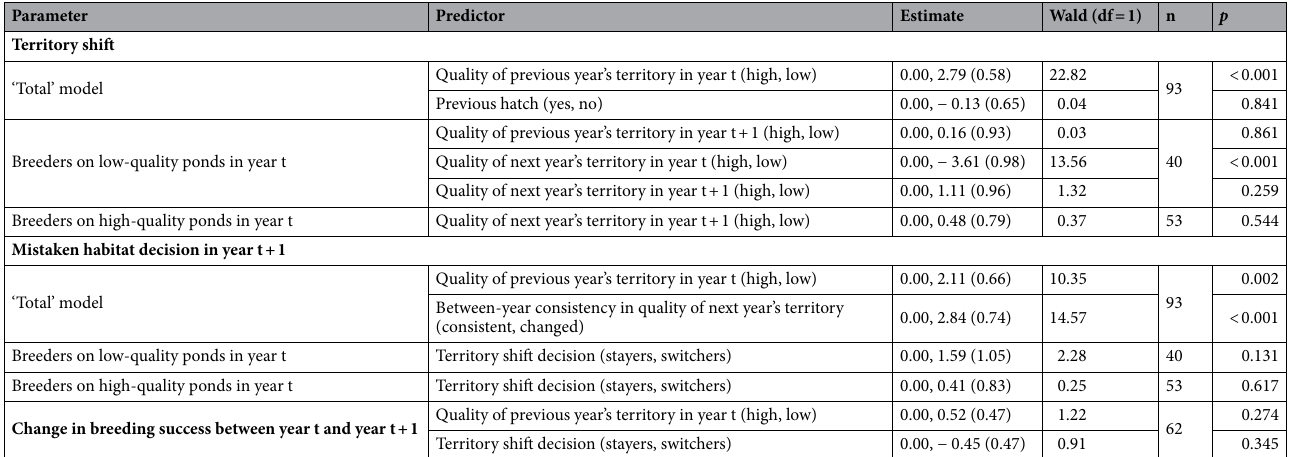
Table 1. Results of GLMMs of the probability of shifting territory between years and making appropriate habitat selections (models with binomial errors and logit link function), and the probability of between-year change in breeding success (model with normal errors and identity link) of red-necked grebes nesting on fish ponds of contrasting habitat quality. The models incorporate bird (pair) identity as a random effect. Non- significant interaction terms ( p > 0.1) were excluded. Standard errors of effect estimates are given in brackets; for categorical factors, standard errors of differences are presented. Sample sizes for each model are reported. Settling on low-quality ponds was considered a mistaken habitat decision.